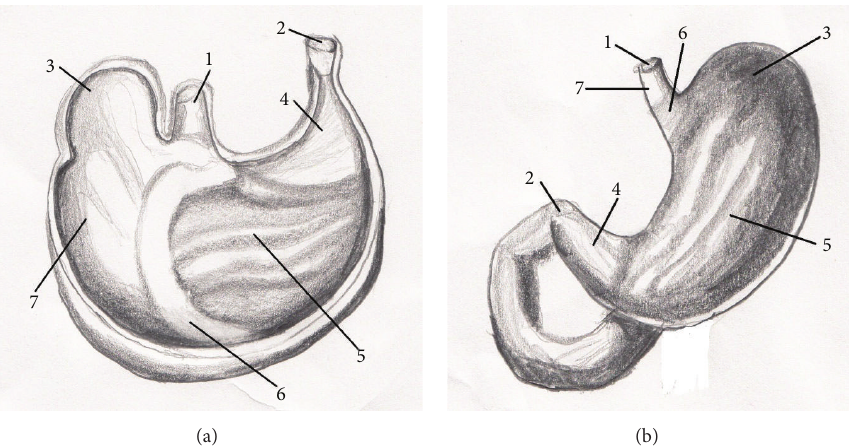
Figure 2: The comparative anatomy of gastric mucous membrane in rat and human. 1: pars cardiaca , 2: pars pylorica , 3: fundus ventriculi , 4: glandulae pyloricae , 5: glandulae gastricae propriae , 6: glandulae cardiacae , 7: pars nonglandularis , (a) rat stomach ( facies visceralis ), and (b) human stomach ( paries anterior ).